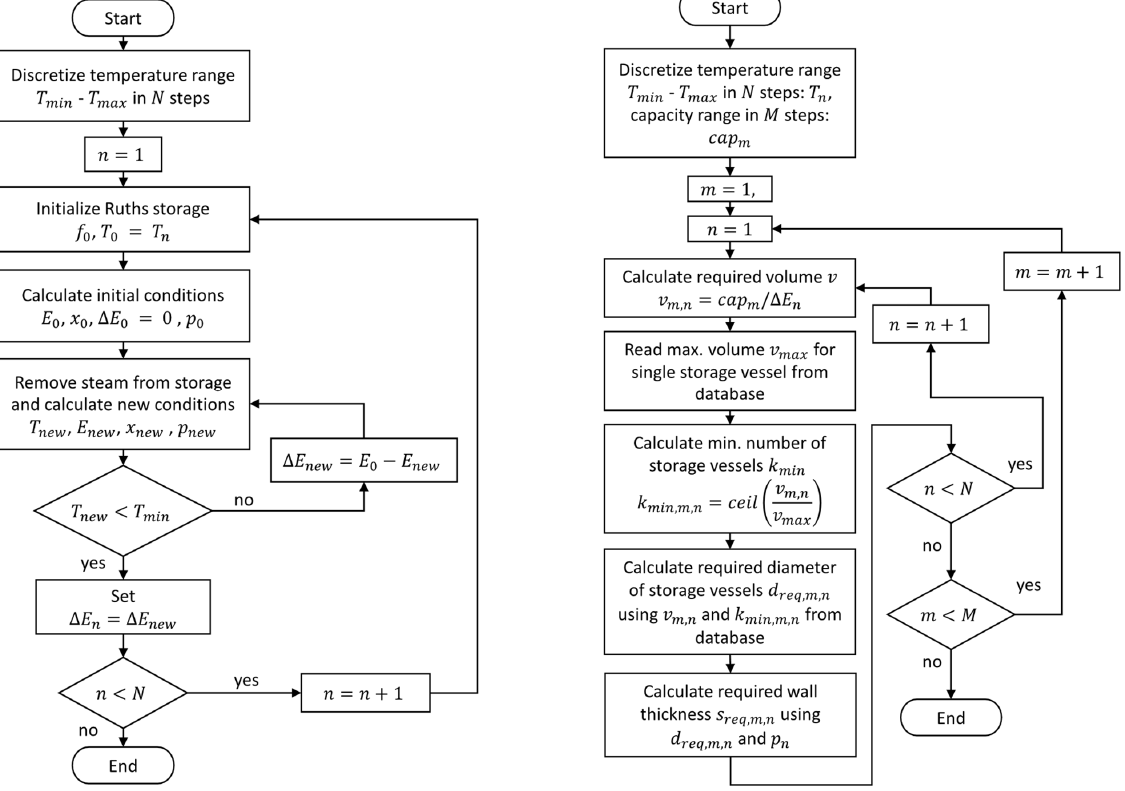
Figure 2. Ruths steam accumulator: calculation of vessel capacities ( left ) and calculation of storage parameters ( right ).